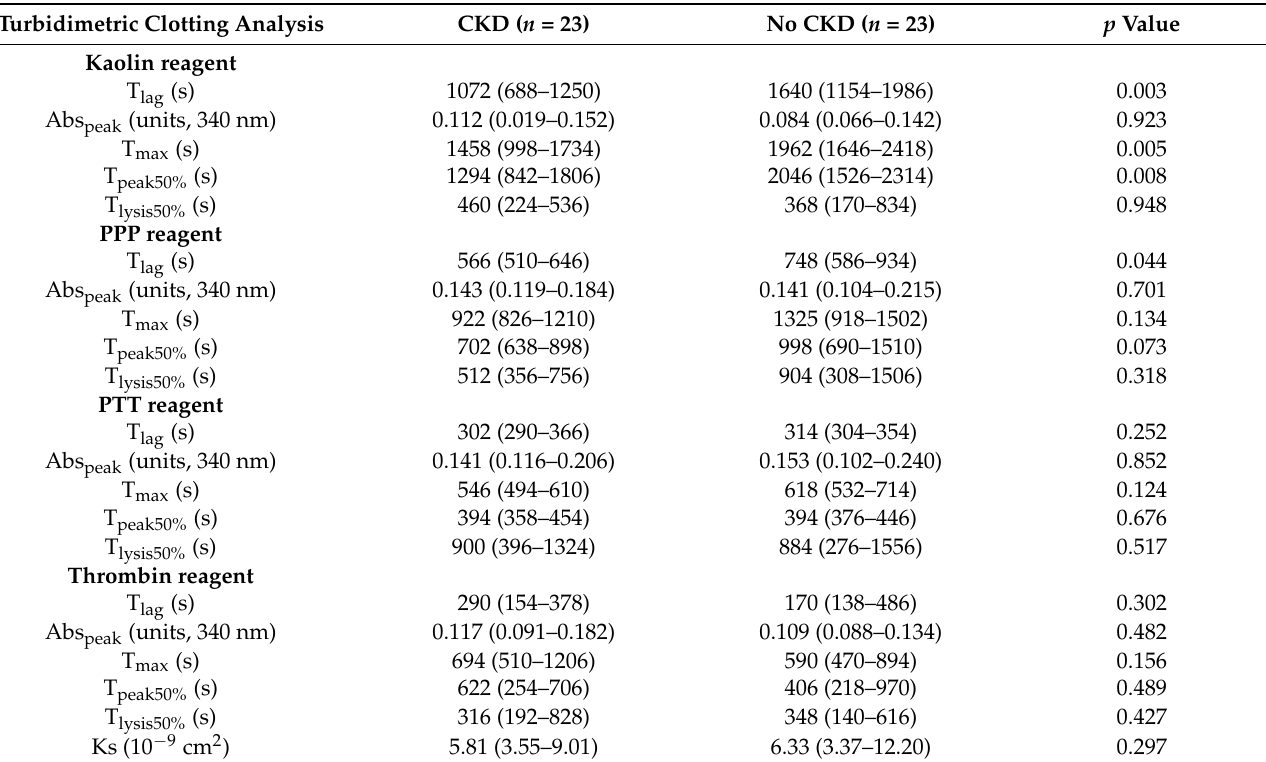
Table 4. Fibrin clot properties among atrial fibrillation patients with and without chronic kid- ney